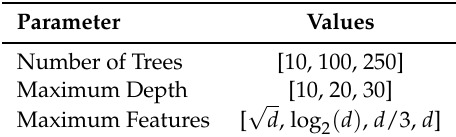
Table 4. Hyperparameter search intervals for the Random Forest and Extra Trees algorithms. d denotes the dimensionality of the input features for